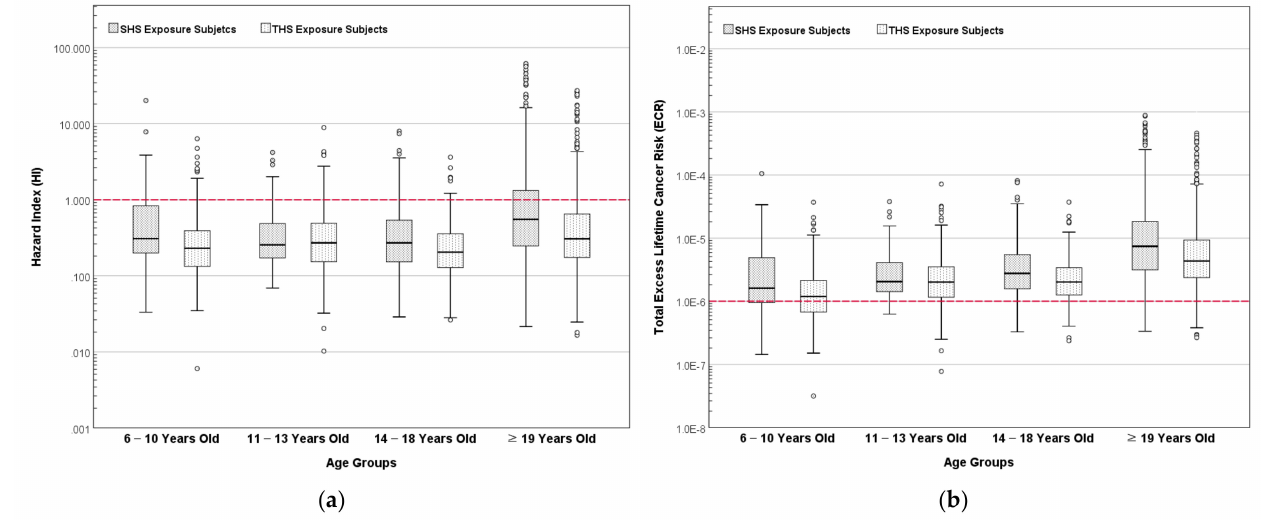
Figure 7. Assessment of ( a ) hazard index and ( b ) total excess lifetime cancer risk for the composition of cigarette smoke to ETS exposure subjects based on